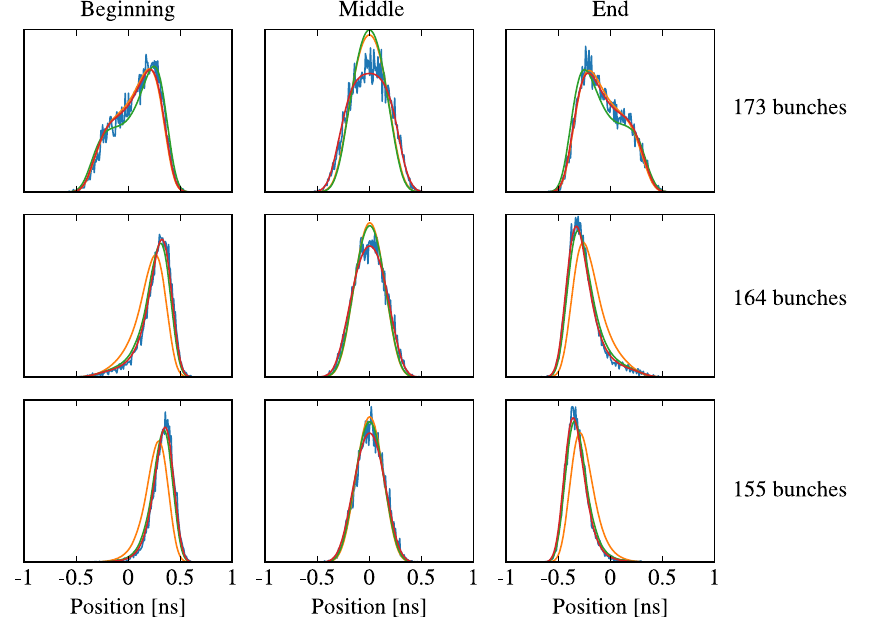
calibration.FIG. 8. Bunch profiles for beginning (left), middle (center), and end (right) of the bunch train for fill patterns with 173 (top), 164 (center), and 155 (bottom) filled buckets. The colors are in accordance with Fig. 7, MBTRACK (blue), form factor 1 (orange), scalar form factor (green), and complex form factor